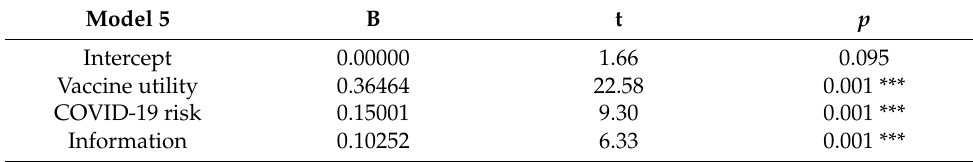
Table 2. Regression analysis: variables for happiness.